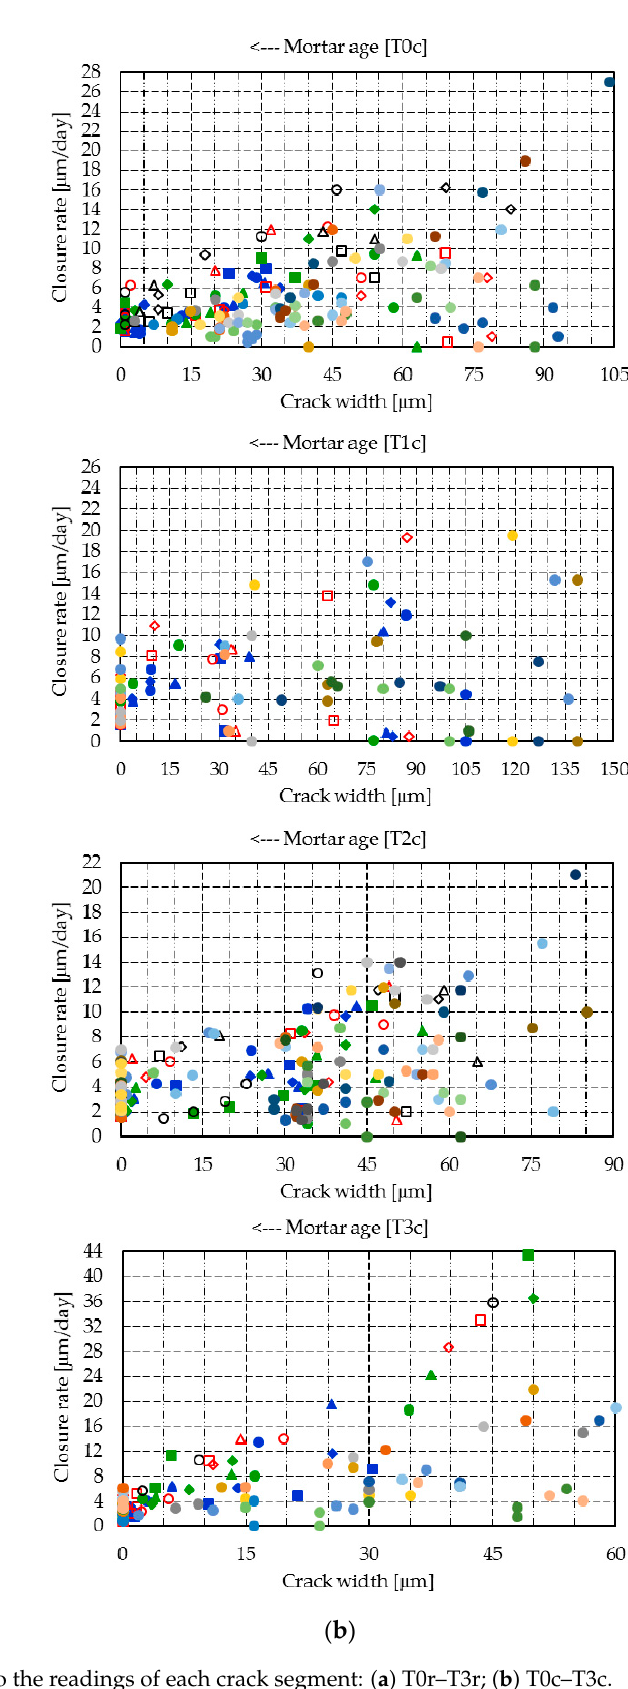
Figure 11. Mean closure rates in mixtures T0c–T3c.